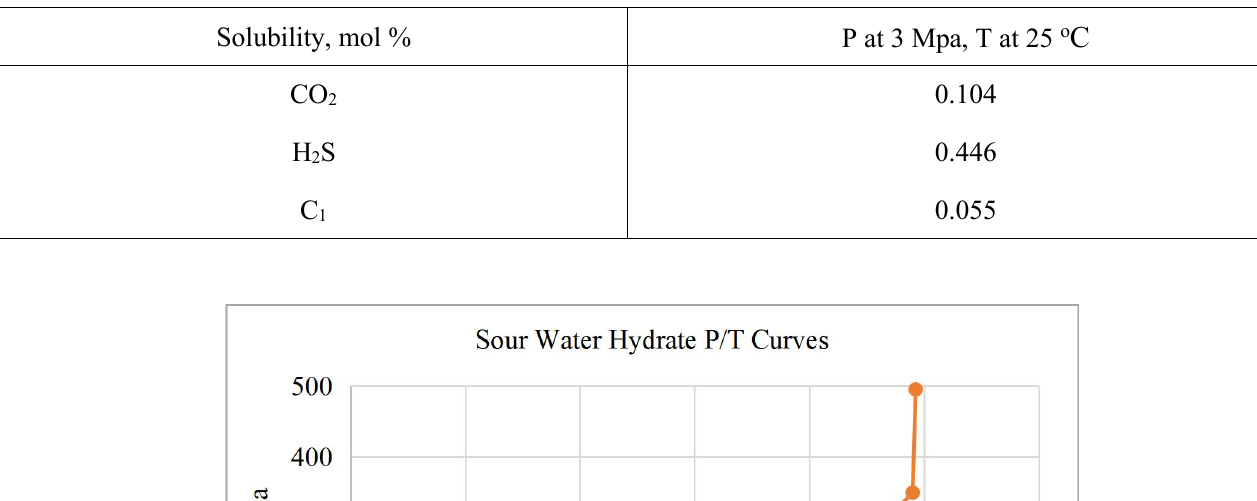
Table 1—Solubility of each gas component in water.